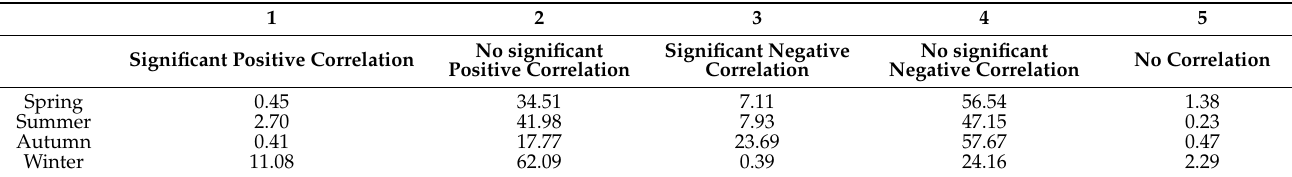
Table 13. Area proportion of correlation level between FVC and SSD